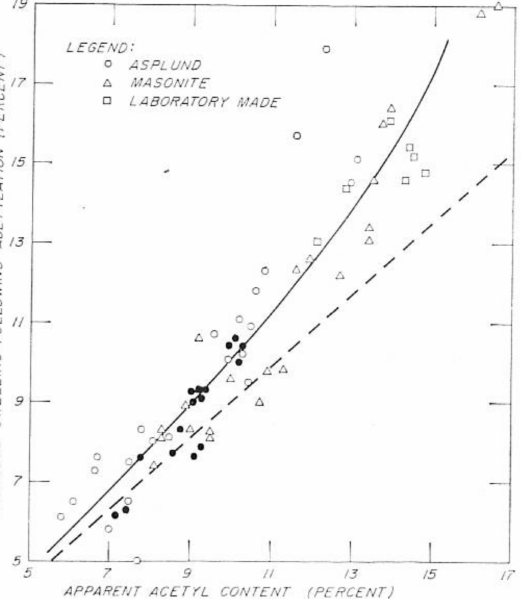
Figure 9. Increase in dry thickness due to acetylation versus acetyl content for Asplund and Masonite hardboards